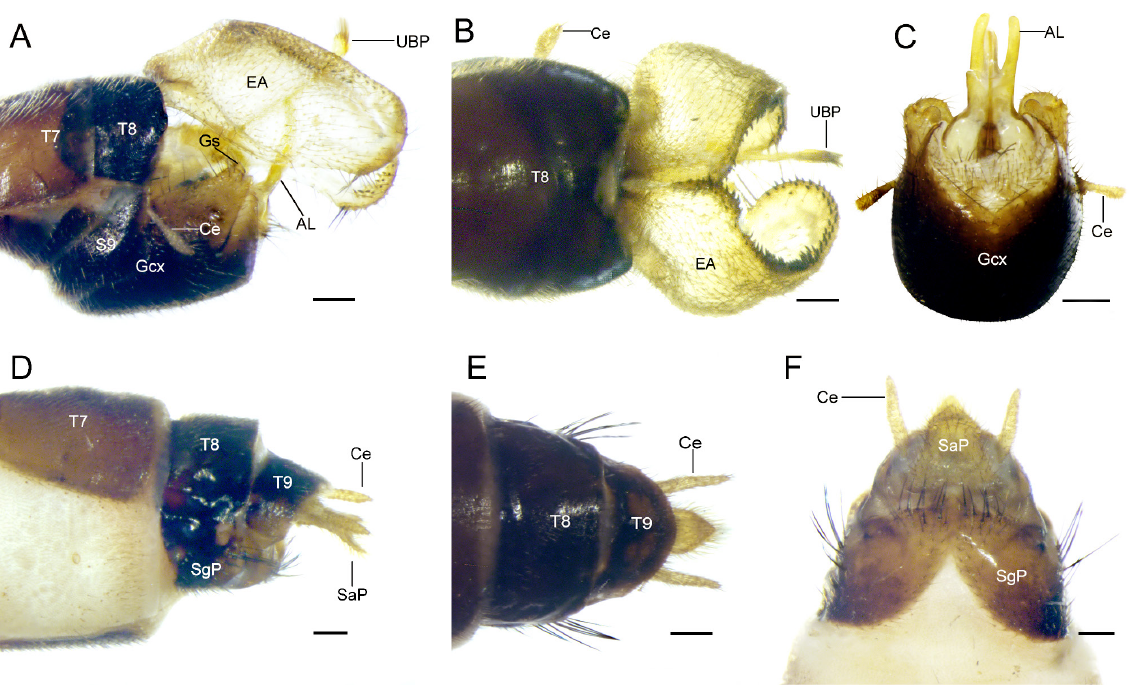
Fig. 10. Bittacus multisetus sp. nov. A–C . ♂, holotype (NWAU). A . Terminalia in lateral view. B . Terminalia in dorsal view. C . Terminalia in posterior view. D–E . ♀, paratype (NWAU). D . Terminalia in lateral view. E . Terminalia in dorsal view. F . Terminalia in ventral view. Abbreviations: see Material and methods. Scale bars = 0.2